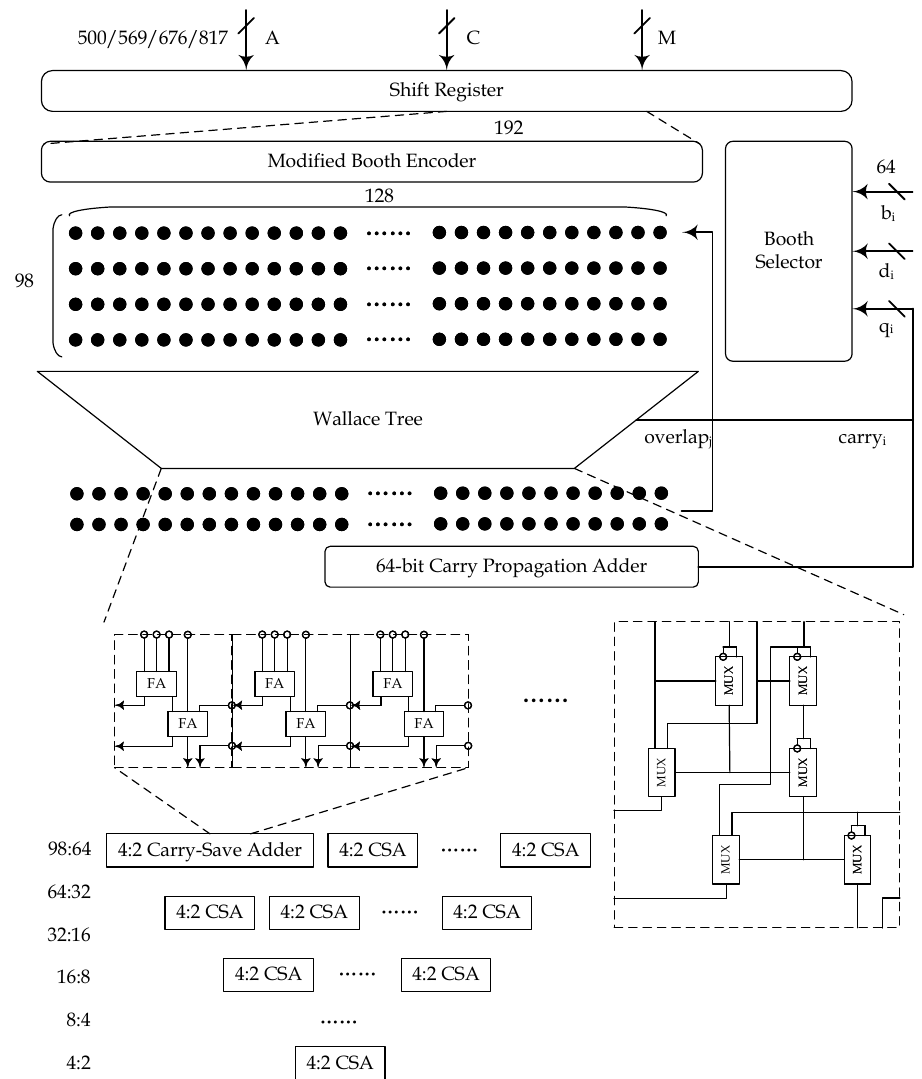
Figure 5. Schematic of quadratic field modular